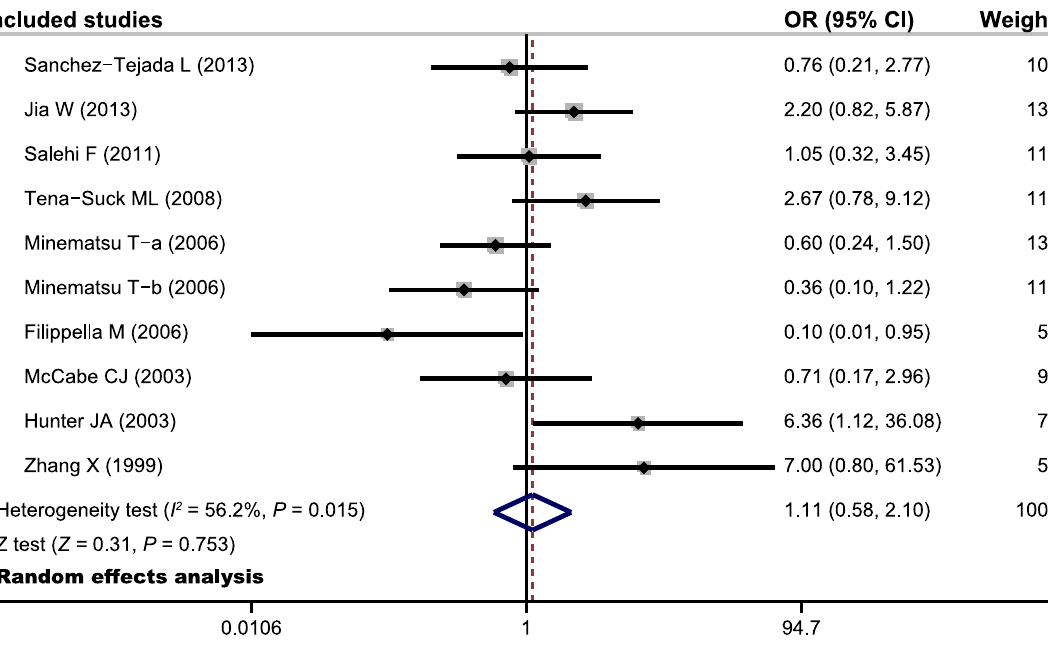
Figure 5. Forest plots for the relationship between PTTG expression and functional status of pituitary adenomas.